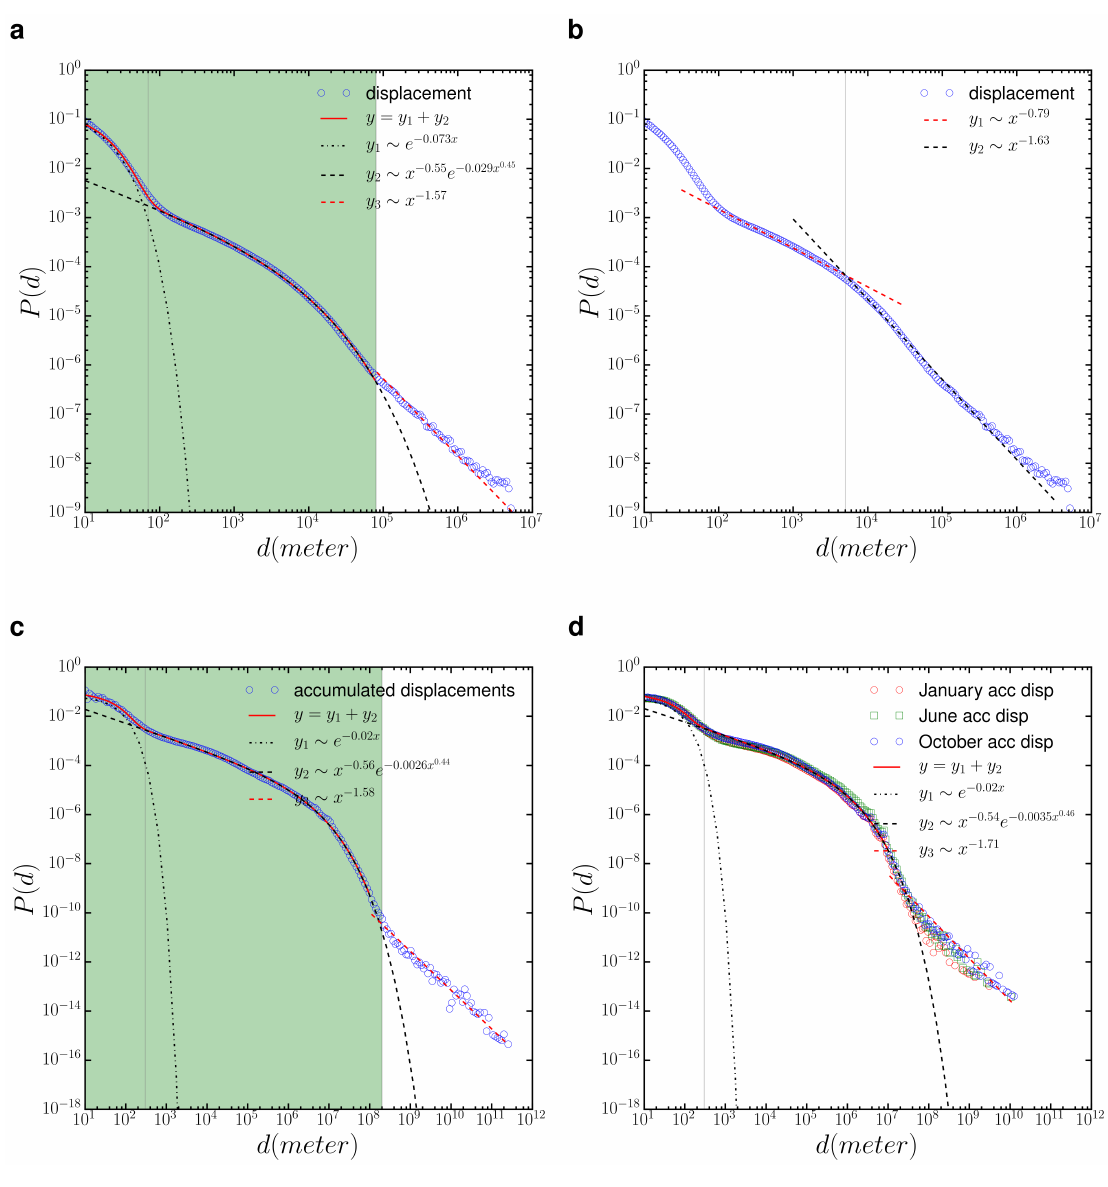
Figure 4. ( a ) The probability distribution of the collective Twitter user displacements P(d); ( b ) the distance between [100 m, 80 km] is approximated by a double power-law functions; ( c ) The probability distribution of the accumulated displacements of individual Twitter users P(d); ( d ) The probability distribution of the accumulated displacements of individual Twitter users in 3 different